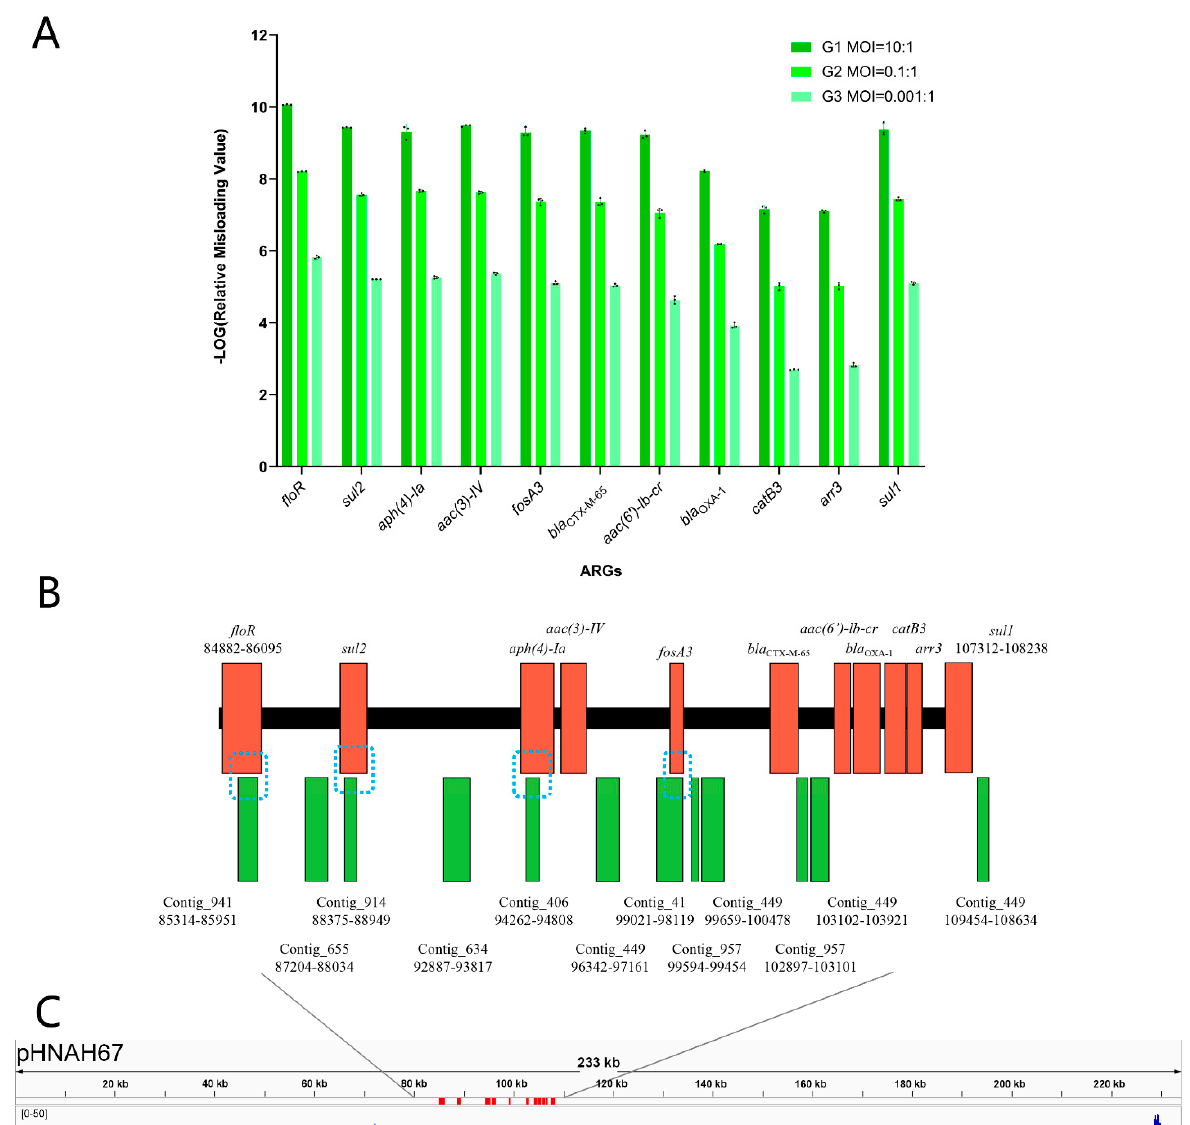
Figure 6. ( A ) Relative misloading value of 11 ARGs in “misloaded phage”. Results for qPCR assays indicated differences for ARG transmission through generalized transduction in three groups. It is worth noting that the y -axis represented the negative logarithm of relative misloading value. ( B ) Matching positions of ARGs between contigs and plasmid pHNAH67. The blue dotted frames indicate the alignment of four contigs and ARG sequences. ( C ) Plasmid pHNAH67 genome coverage pattern associated with generalized transducing by phage AH67C600_Q9. Whole genome sequencing reads were mapped to plasmid in blue. The red regions on the sequence are the 11